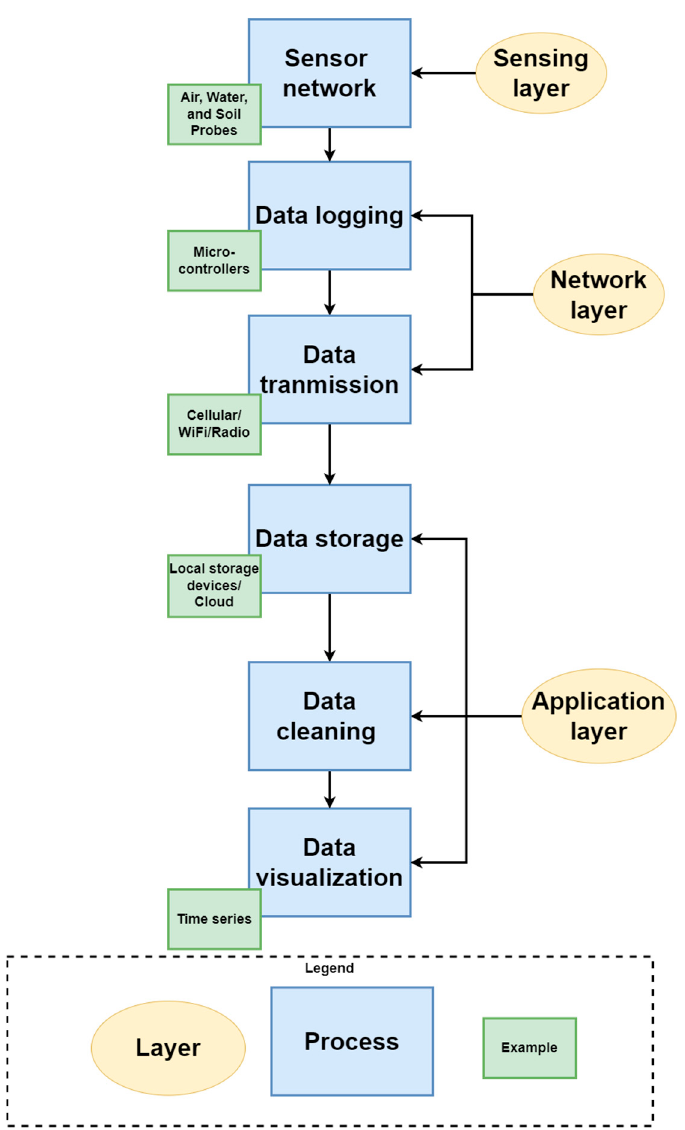
Figure 1. Schematic diagram of IoT architecture for real-time environmental monitoring applica- tions .